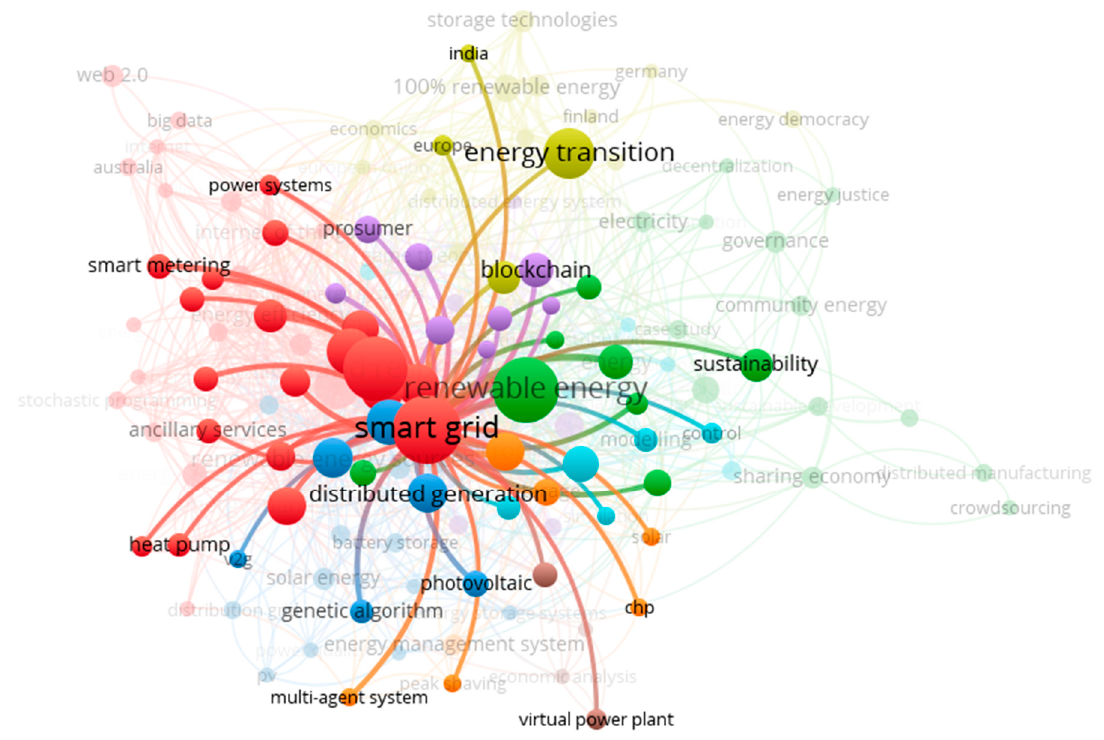
Figure 12. Highlighting the connections around ‘smart grid’.